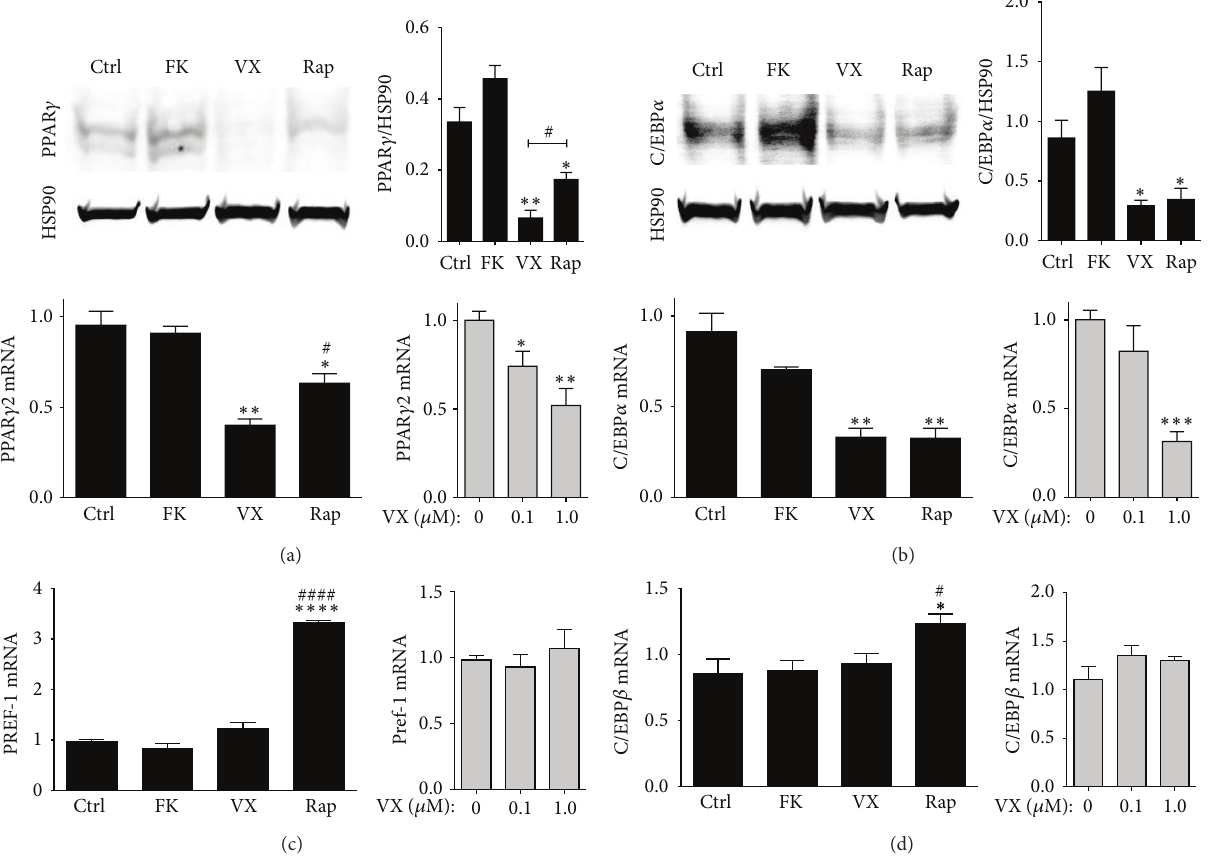
Figure 4: Timcodar and rapamycin reduce expression of adipogenic regulators. Western blot and densitometry for (a) PPAR 𝛾 and (b) C/EBP 𝛼 , as well as real-time PCR analysis of differentiated 3T3-L1 adipocytes treated with vehicle (Ctrl), 1 𝜇 M FK506 (FK), 1 𝜇 M timcodar (VX), and 1 𝜇 M rapamycin (Rap): (a) PPAR 𝛾 , (b) C/EBP 𝛼 , (c) PREF-1, and (d) C/EBP 𝛽 . Real-time PCR for a dose-dependent increase of timcodar for treatments of 0 𝜇 M, 0.1 𝜇 M, or 1.0 𝜇 M in gray boxes: (a) PPAR 𝛾 , (b) C/EBP 𝛼 , (c) PREF-1, and (d) C/EBP 𝛽 . ∗ 𝑝 < 0.05 ; ∗∗ 𝑝 < 0.01 ; ∗∗∗ 𝑝 < 0.001 ; ∗∗∗∗ 𝑝 < 0.0001 (versus control); # 𝑝 < 0.05 ; and #### 𝑝 < 0.0001 (timcodar versus rapamycin treatment) ( ± S.E.; 𝑛 = 3